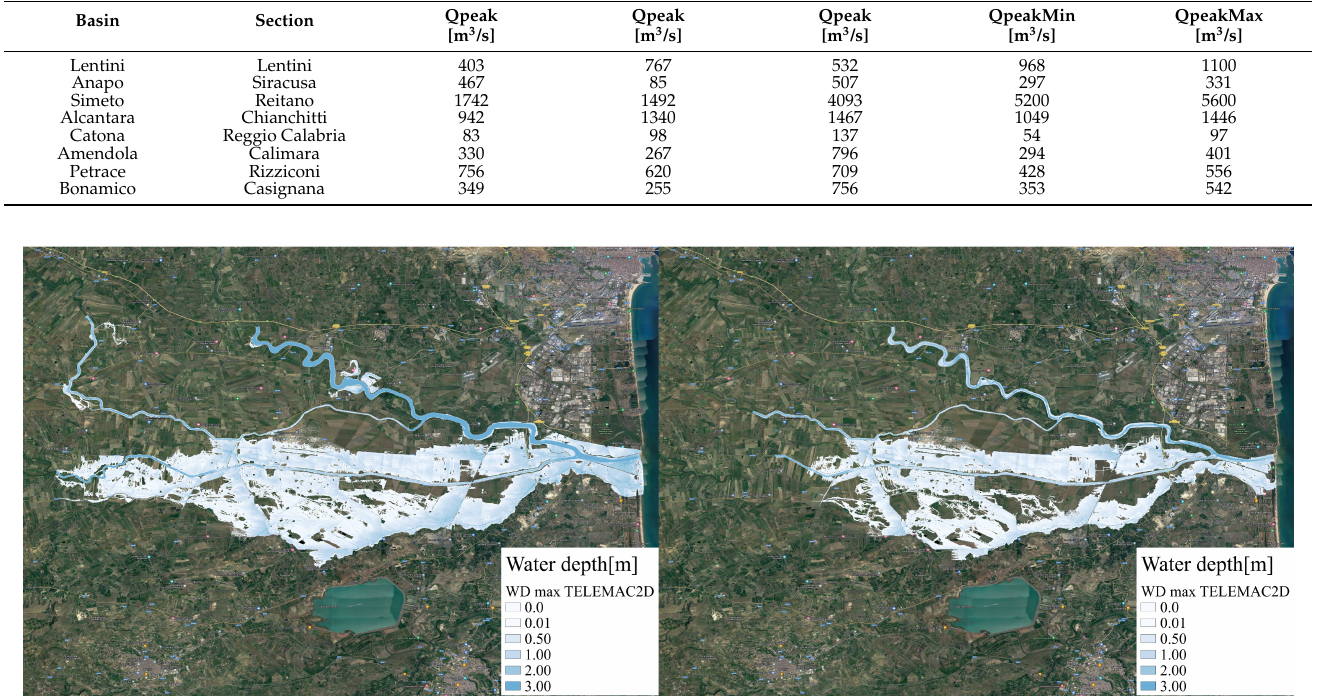
Table 4. Comparison between forecasts and benchmark peak flows. Threshold – criticality is a value of flow for which criticality as flooding or other ground effects happen; the benchmark is the run on observation peak flow; WRF-DA is the forecast chain fed with WRF model that assimilates both radar and ground temperature data; WRF-OL is the forecast chain without assimilation. Threshold Criticality Benchmark WRF-DA WRF-OL Prob.